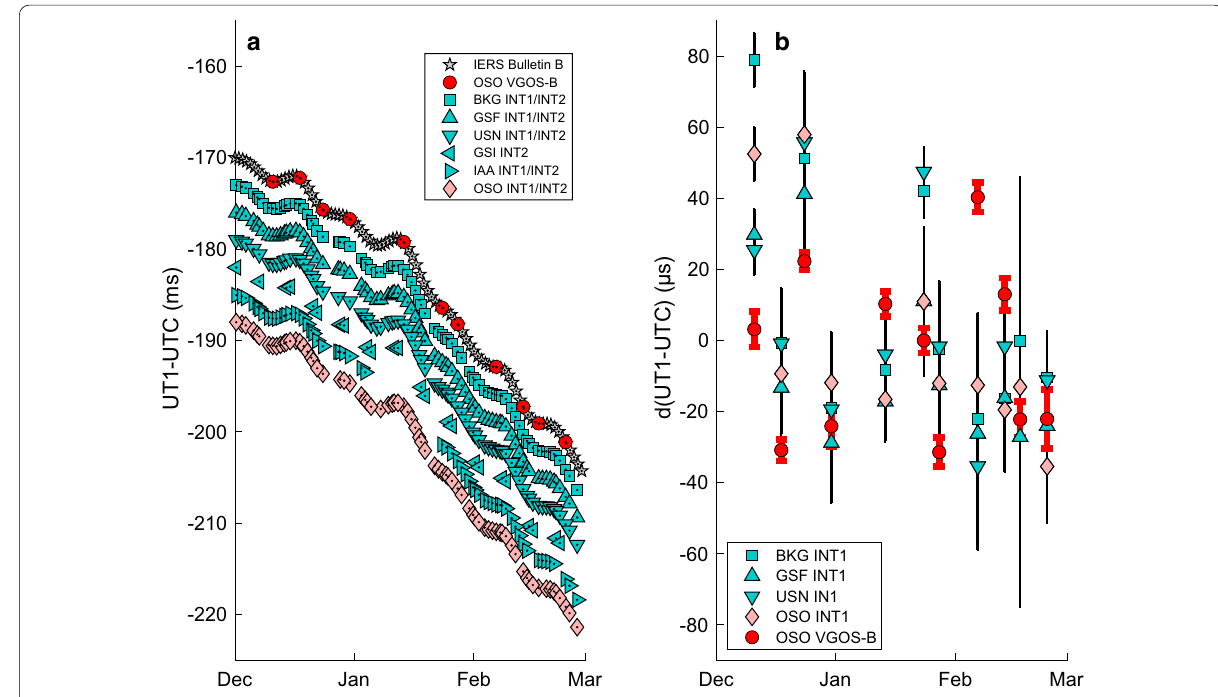
Fig. 3 Left plot a Time series of UT1-UTC for December 2019 through February 2020. Shown are IERS Bulletin B values (grey stars) and the VGOS-B results as (red circles). The light blue symbols show the INT1/INT2 results of BKG (squares), GSF (upward-pointing triangles), USN (downward-pointing triangles), GSI (left-pointing triangles), and IAA (right-pointing triangles). The INT1/INT2 results from OSO are shown as light-red diamonds. To increase readability, all series, except the VGOS-B one, are offset by − 3 ms each from the series shown directly above. Right plot b Differences with respect to IERS Bulletin B values for simultaneously observed INT1 and VGOS-B sessions